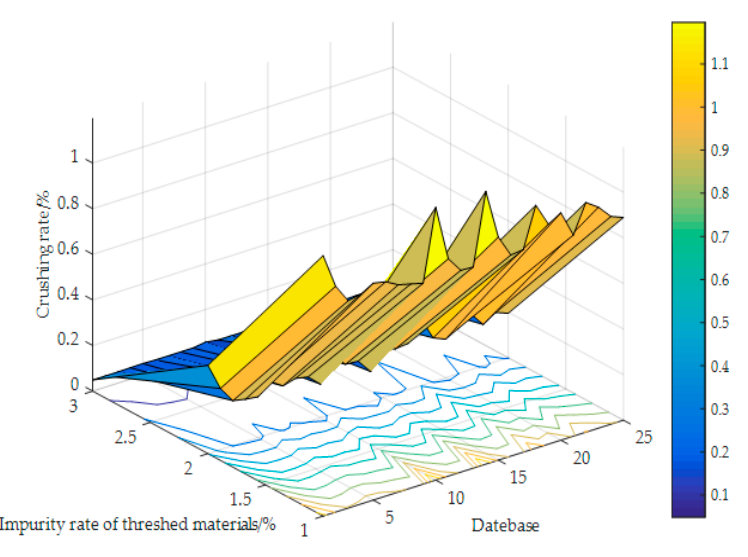
Figure 3. The threshing performance index database for the artificial neural network.